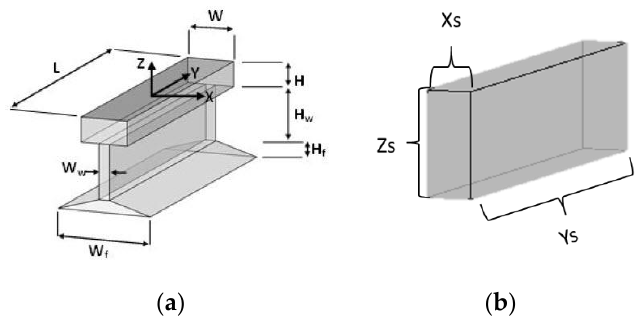
Figure 3. Rail piece model; ( a ) the original model [11] and ( b ) the model considered in this research.